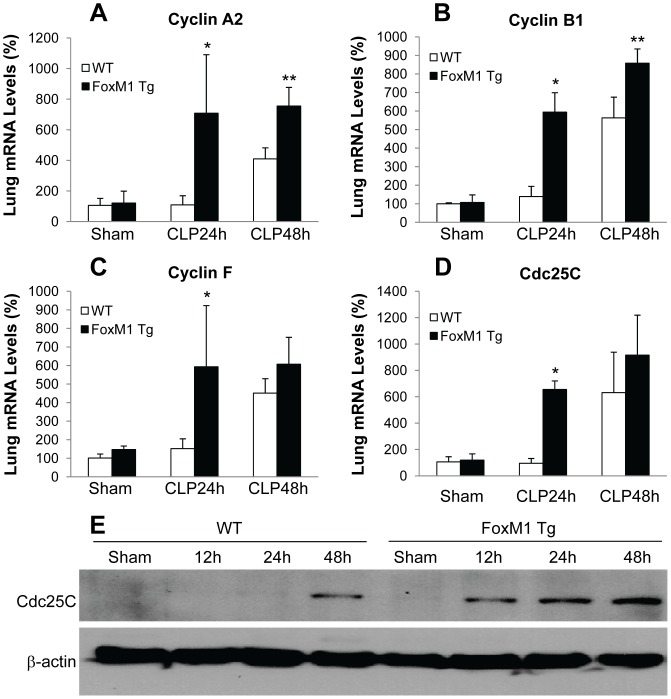
Early induction of expression of FoxM1 target genes essential for cell cycle progression in FoxM1 Tg lungs.(A–D) QRT-PCR analysis of expression of FoxM1 target genes. Lung tissues were collected at indicated times post-CLP challenge or 24 h post-sham operation for RNA isolation and QRT-PCR analysis. Data are expressed as mean ± SD (n = 3–5 per group). *, P<0.001 versus WT; **, P<0.05 versus WT. (E) Representative Western blotting demonstrating FoxM1-mediated induction of Cdc25C protein expression. Lung tissues were collected at various times post surgery and lysed for examination of Cdc25C protein levels by Western blotting. The same membrane was blotted with anti-β-actin as a loading control. The experiment was repeated three times with similar data.